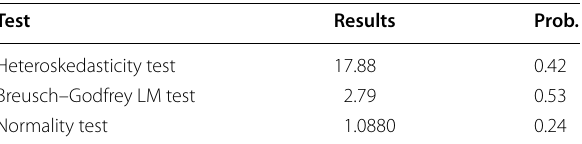
Table 8 Diagnostic test. Source : Authors